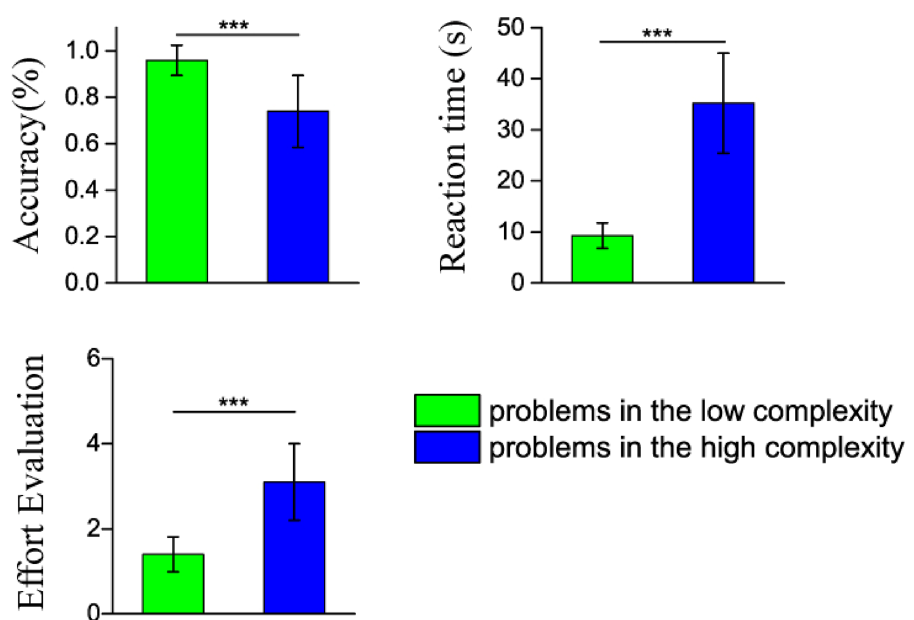
Figure 1. Mean reaction time, response accuracy and subjective effort evaluation for the low and high complexity problems. The behavioral results support that our scientific problem design and complexity categorization are reliable. The experiment successfully engaged the students in solving scientific problems with different levels of mental effort. *** p <